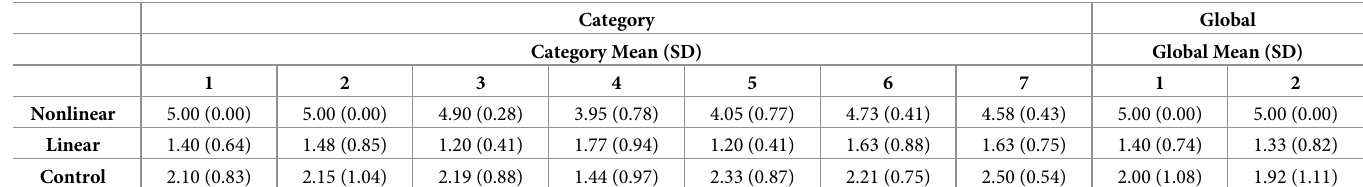
Table 2. Pedagogical fidelity checklist